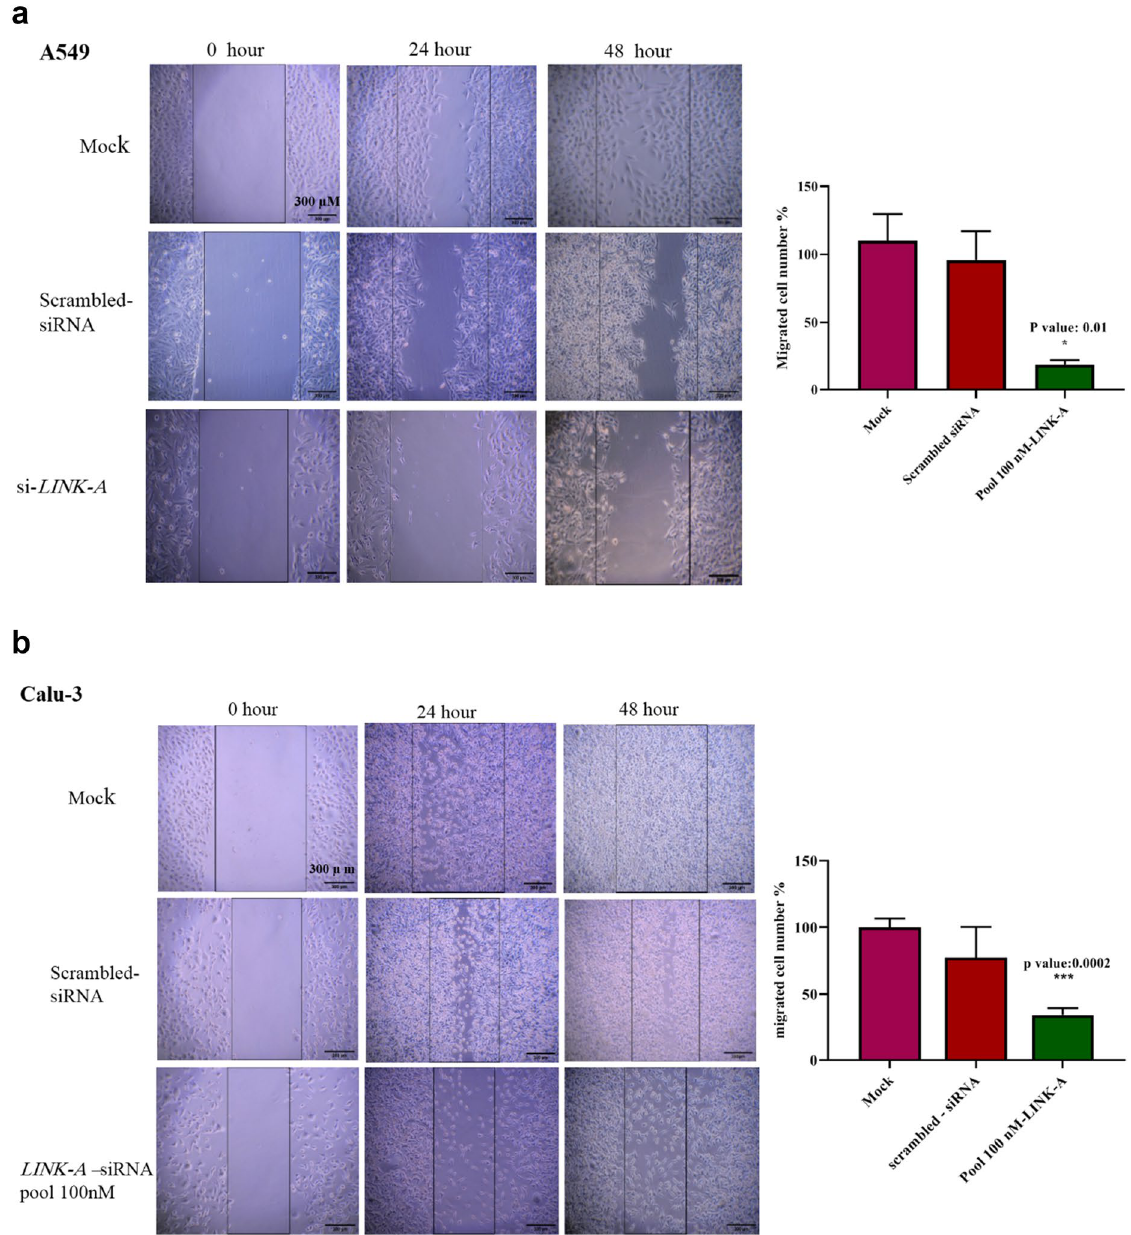
Figure 3. LINK-A knockdown effect on mobility of A549 ( A ) and Calu-3 cell lines ( B ) as assessed by the wound healing assay. Note . Images of scratched control cells (mock, scrambled siRNA transfected cells) and LINK-A siRNA (pool 100 nM) transfected cells in time points of 0, 24, and 48 hours after creation of scratch with objective magnification 10×. The wound edges were delineated by black lines and the numbers of migrated cell numbers in the wound areas were counted for each field by ImageJ software. The graphs are presented as the mean ± SD (* P < 0.05, *** P <